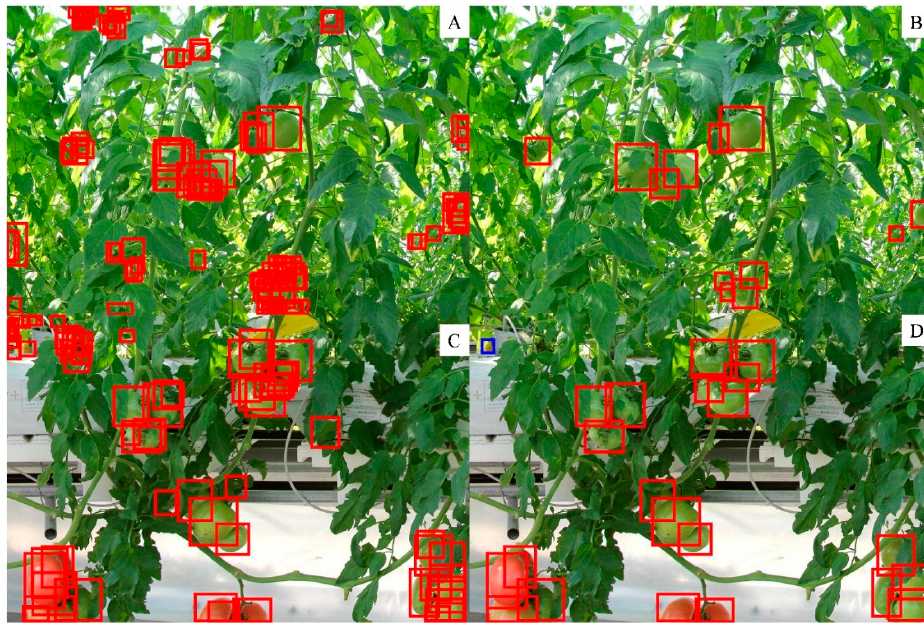
Figure 6. Example of all detected tomatoes ( A and C ) and filtered detected tomatoes with a